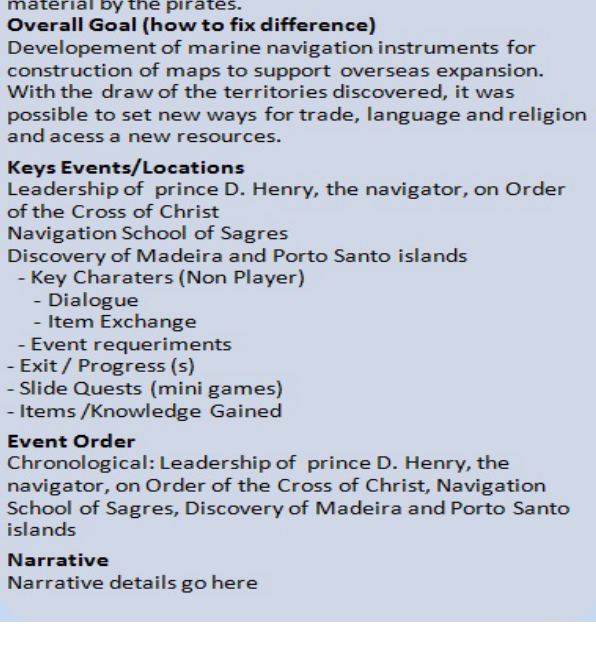
Figure 5. A partially complete example